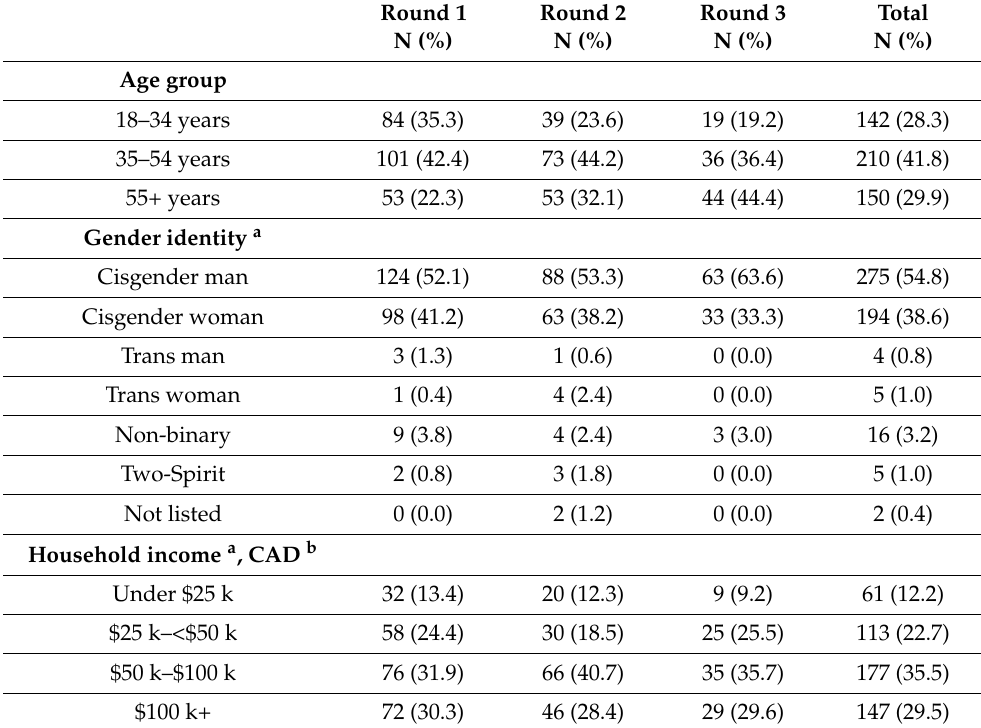
Table 1. Socio-demographic description of LGBTQ2+ respondents to a national Canadian repeated survey regarding mental health during the COVID-19 pandemic,